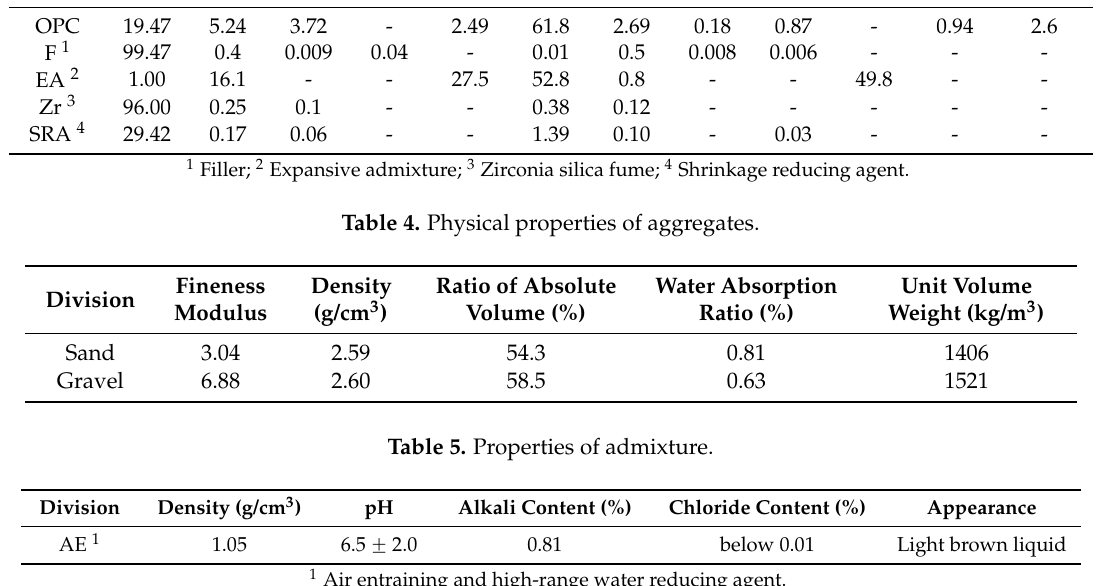
Table 3. Chemical composition of binder.